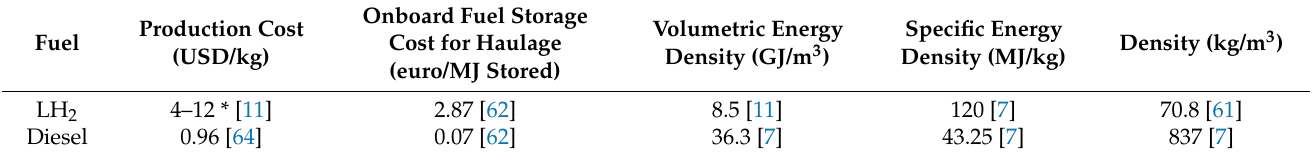
Table 1. Diesel and LH2 costs and properties.